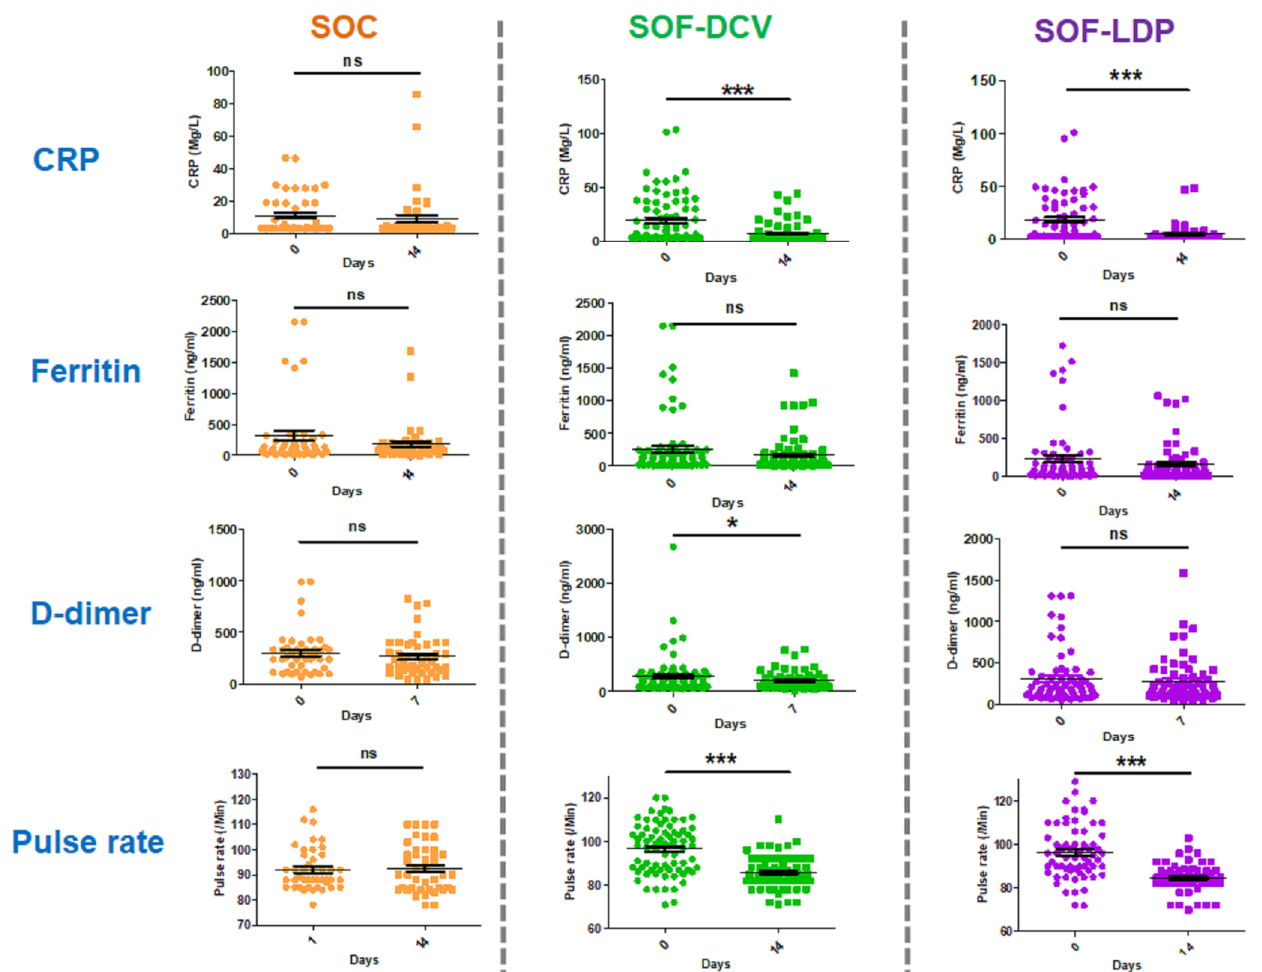
Figure 4. Longitudinal analysis of inflammatory parameters ( A ) CRP ( B ) Ferritin and cardiac health parameters ( C ) D-Dimer and ( D ) pulse rate for SOF/DCV and SOF/LDP treatments compared to SOC. DCV: Daclatasvir; LDP: Ledipasvir; SOF: Sofosbuvir; SOC: Standard of care. *: p < 0.05; ***: p < 0.001.